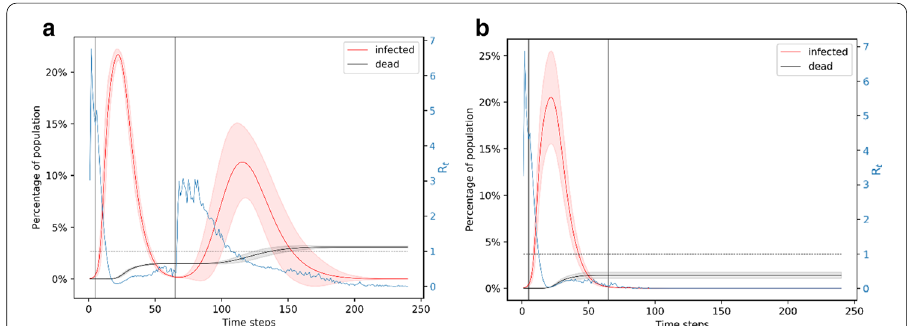
Fig. 5 Simulation of the 60-day lockdown from day 5 to day 65. a Representation of the ~ 40% of simulation results where there is a second wave of infection when the lockdown is from day 5 to day 65. The effective reproduction number increases dramatically after the end of the lockdown, foreshadowing the second peak of the infection. b Representation of the ~ 24% simulation results where there is no second wave of infection for the lockdown period of day 5 to day 65. The effective reproduction number stays below 1 after the lockdown is lifted